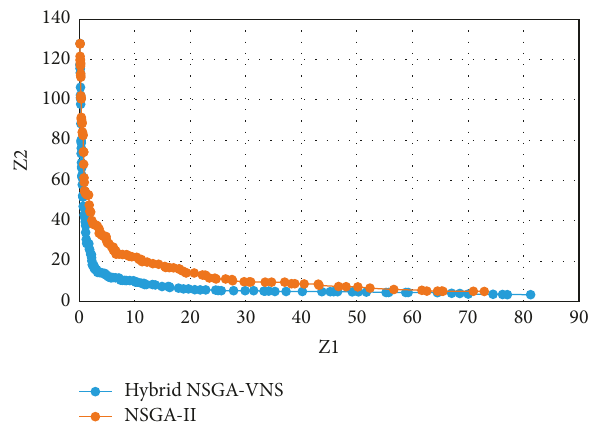
Figure 4: Pareto optimal solutions for different